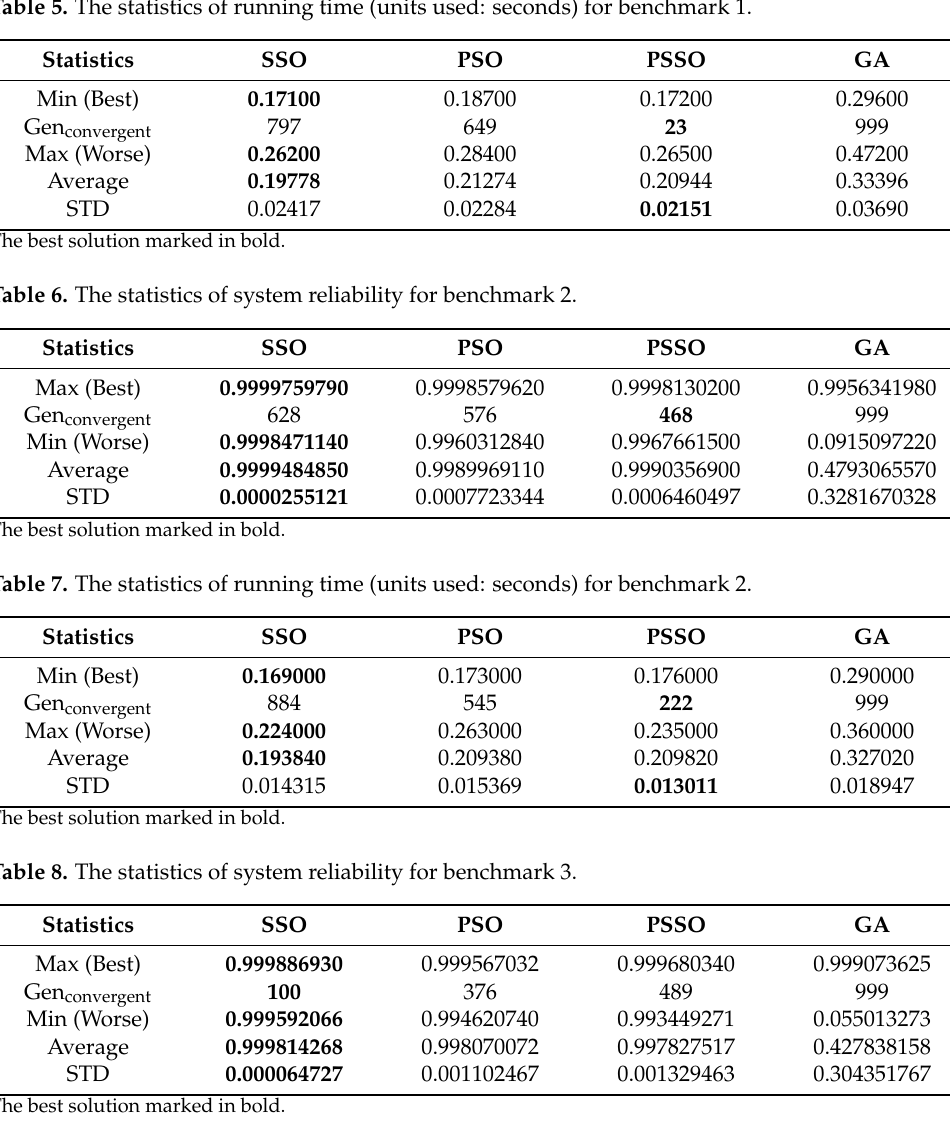
Table 9. The statistics of running time (units used: seconds) for benchmark